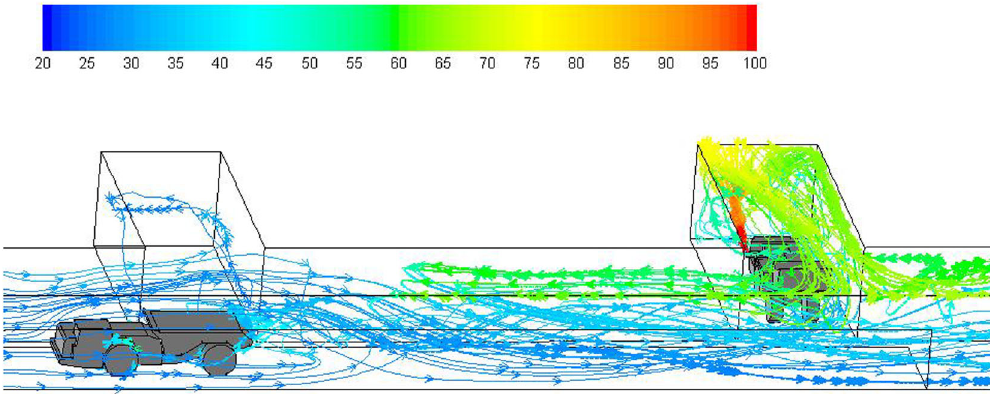
Fig. 7 Pathlines colored by temperature ( (cid:3) C) showing general flow features during the hauling operation (legend 20–100 (cid:3)